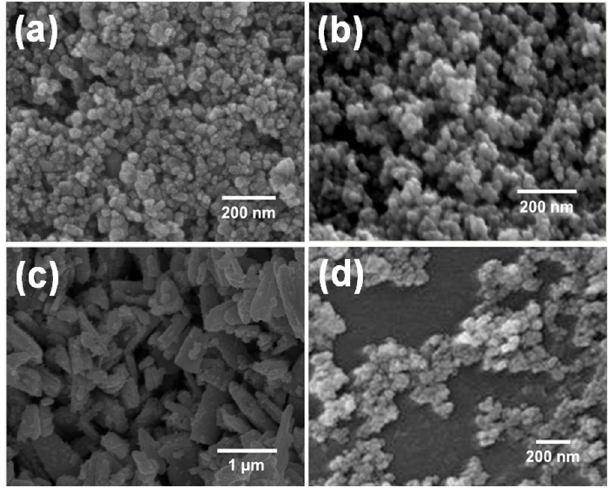
Figure 1. Microstructures of the four gas-sensing materials: ( a ) Pd-doped SnO 2 ; ( b ) In 2 O 3 ; ( c ) Ru-doped WO 3 ; ( d ) Pd-doped SnO 2 ‐ ZnO.